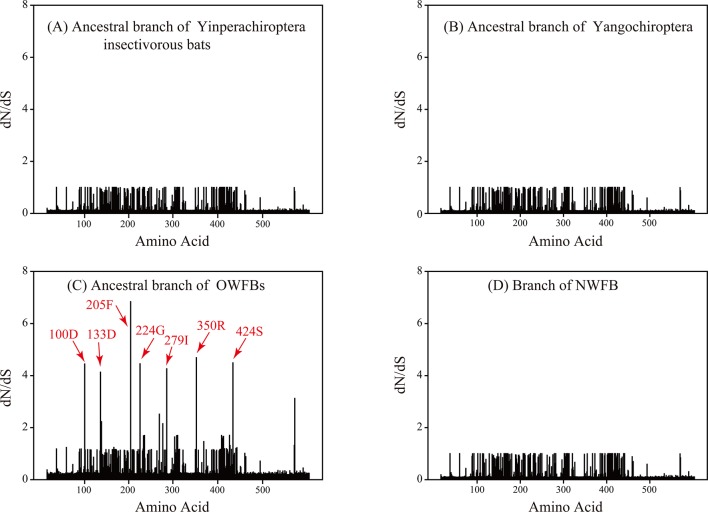
Omega (dN/dS) values of sites along the Nrf2 protein sequence on selected branches.(A) Ancestral branch of Yinpterochiroptera insectivorous bats, (B) ancestral branch of Yangochiroptera, (C) ancestral branch of Old World fruit bats (OWFBs), and (D) branch of New World fruit bat (NWFB). The red arrows indicate the positions of the seven amino acid replacements in OWFBs with elevated ω values.